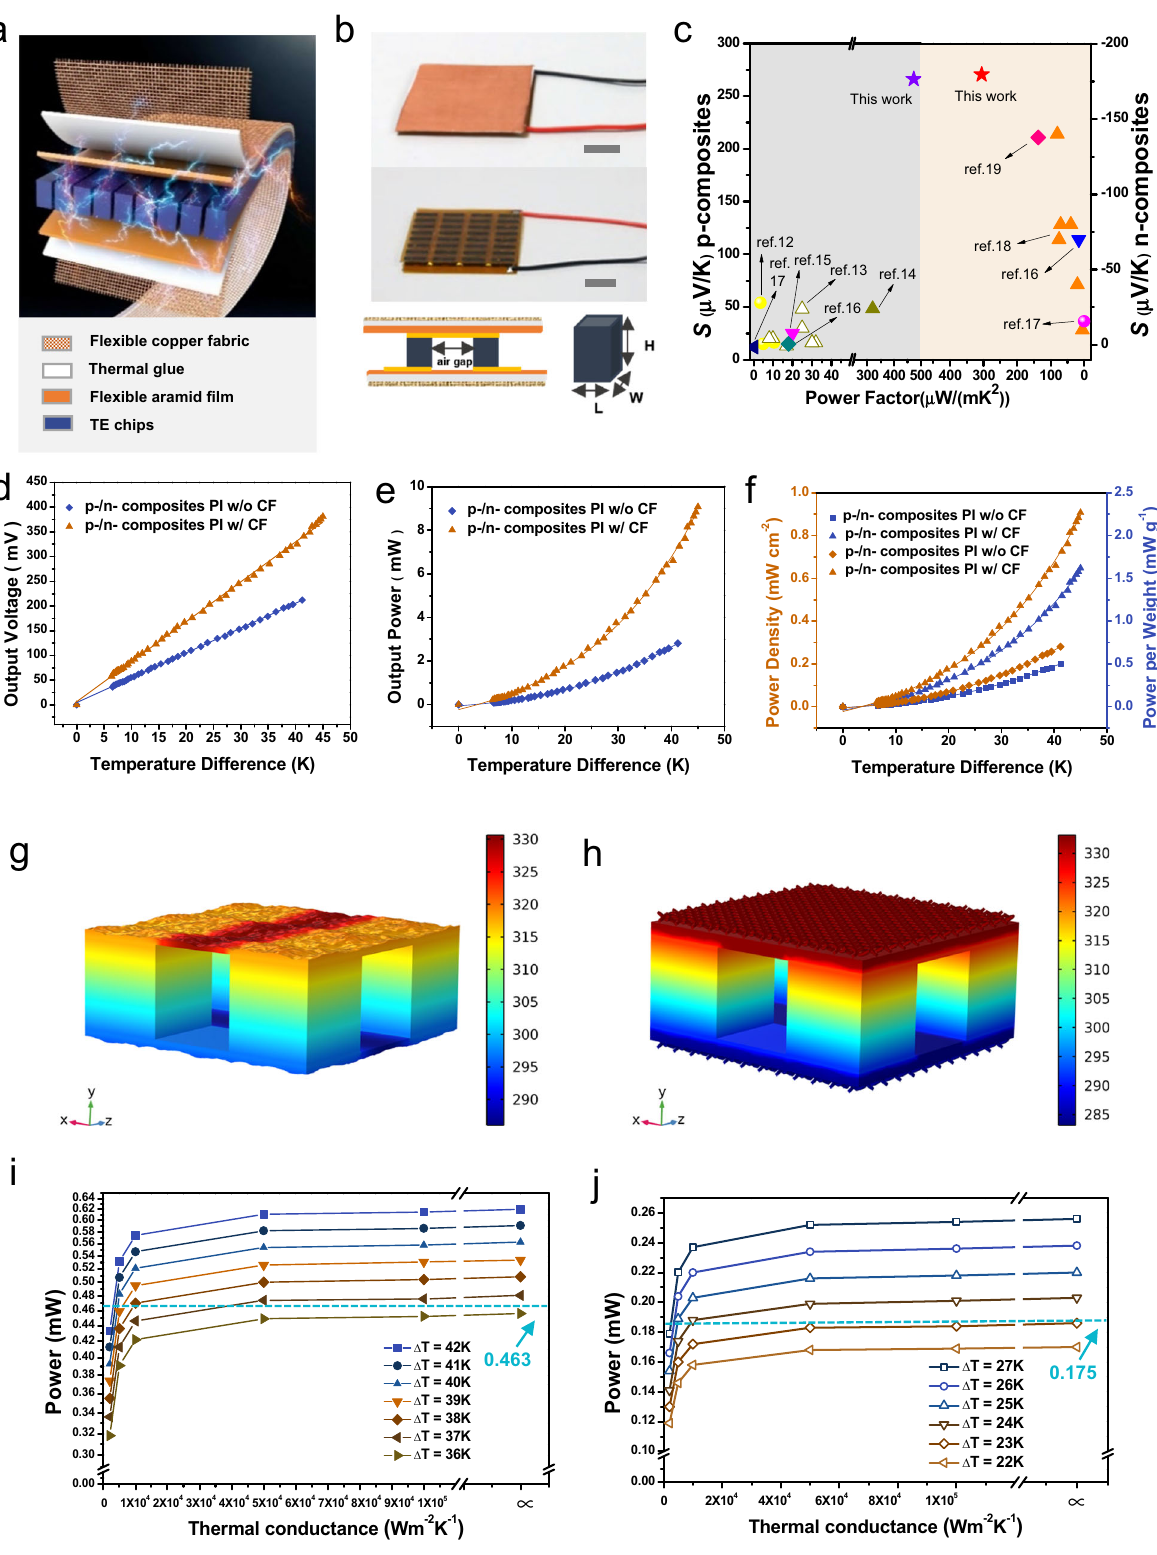
conductivity, the results are also slightly lower than that of the composite samples (see Supplementary Fig. 2). Figure 1d depicts the measured open-circuit voltage as a function of the temperature difference cross the composite FTEG devices with and without copper fabric heat sink. The curves are